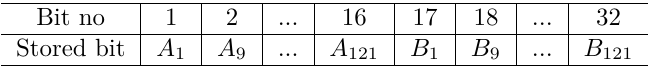
Table 2: Bit allocation for Sbox-wise bit-slicing